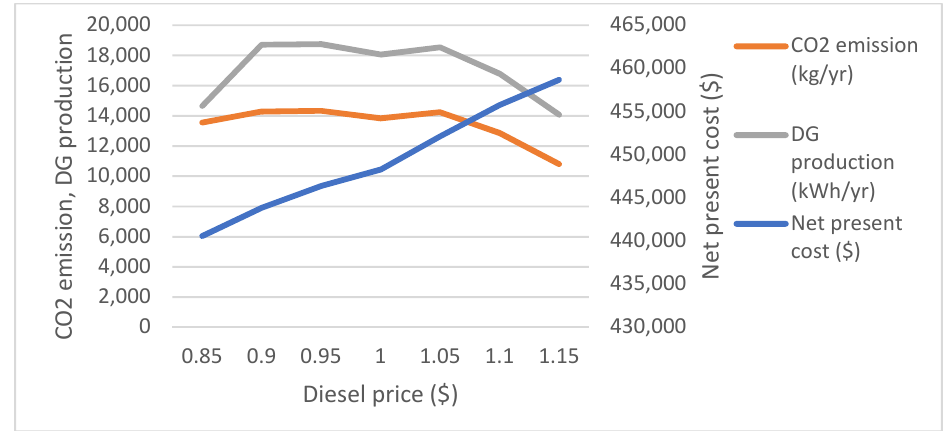
Figure 18. Effect of rising diesel price on CO 2 emission, DG production and net present cost.